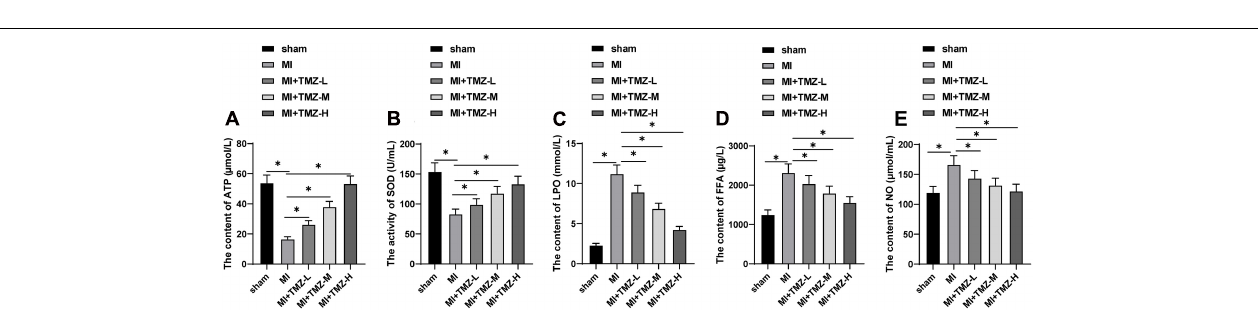
FIGURE 2 | Trimetazidine inhibited MI-induced myocardial energy metabolism disorder. (A) ATP content, (B) SOD activity, (C) LPO content, (D) FFA content, and (E) NO content in the myocardium ( N = 10 per group). All data were expressed as the mean ± standard deviation. Data were analyzed using one-way ANOVA, followed by Tukey’s multiple comparisons test. * P < 0.05. ATP, adenosine triphosphate; SOD, superoxide dismutase; LPO, lipid peroxide; FFA, free fatty acids; NO, nitric oxide.